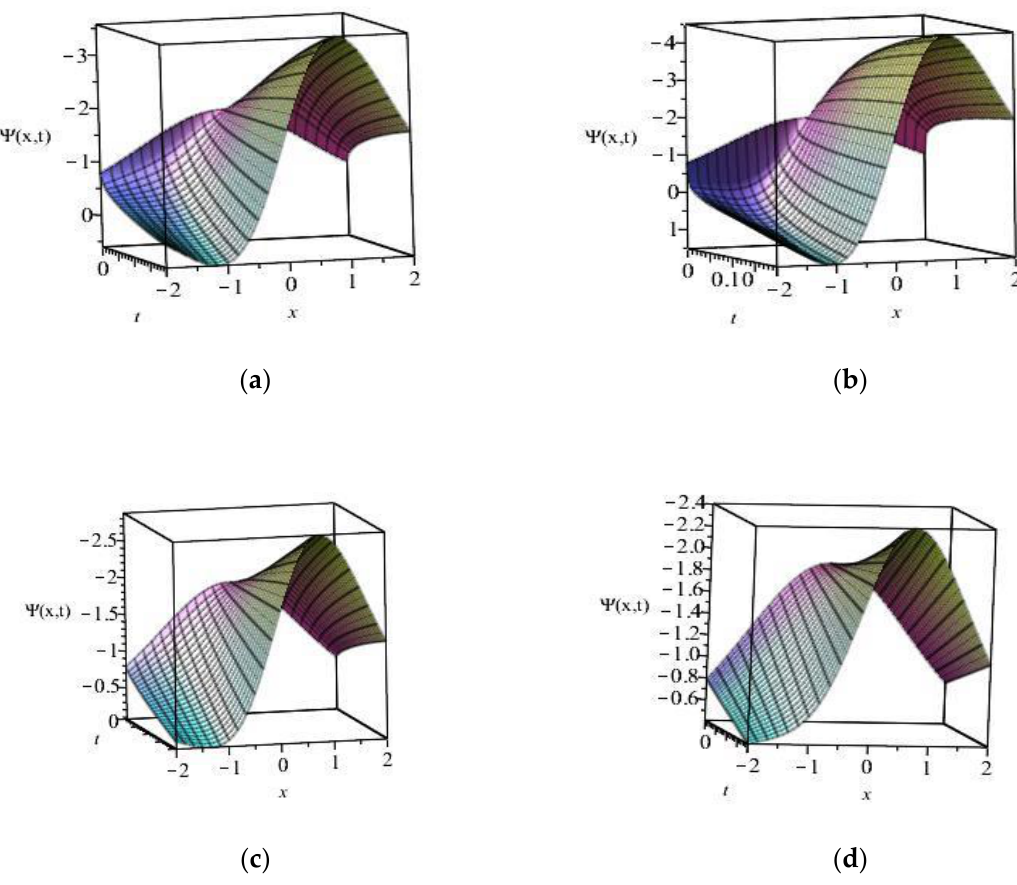
Figure 3. Plots of ψ ( x , t ) with respect to x and t at ( a ) α = 0.5 ( b ) α = 0.25 ( c ) α = 0.75 ( d ) α = 1 for Equation (38).